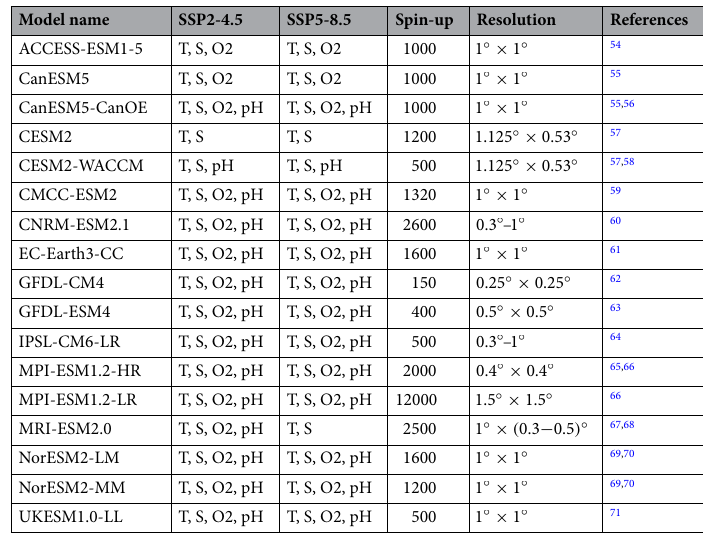
Table 1. List of the 17 Earth system models from the Coupled Model Intercomparison Project phase 6 (CMIP6), their respective variables (T and S denote temperature and salinity, respectively) and scenarios analyzed in this study, their spin-up durations in model years, horizontal resolutions of the ocean component, and